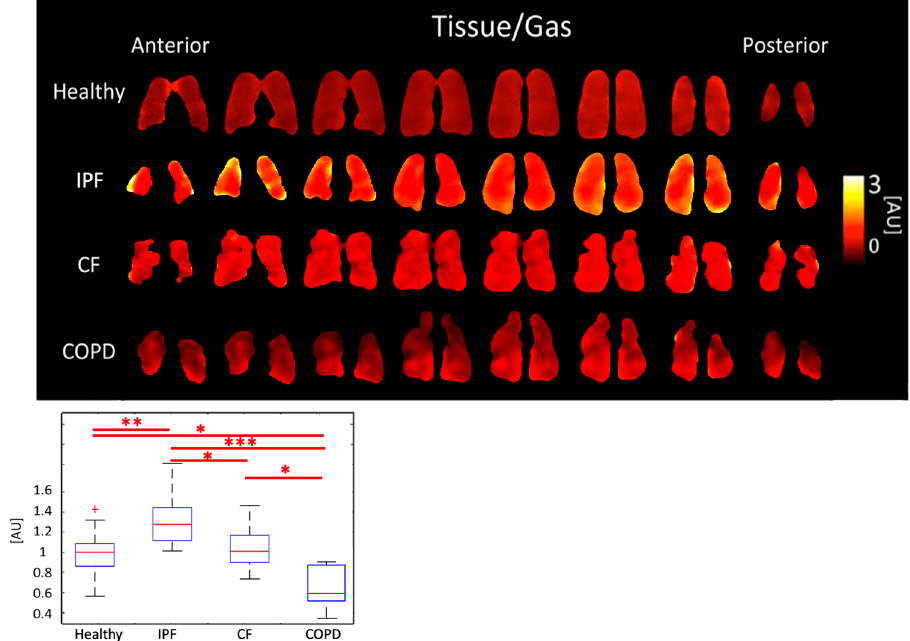
Figure 5. Tissue/Gas ratio maps ( top ) and boxplots ( bottom ) for each disease type. ( p < 0.001 = ***, p < 0.01 = **, p < 0.5 = *, + outlier) .